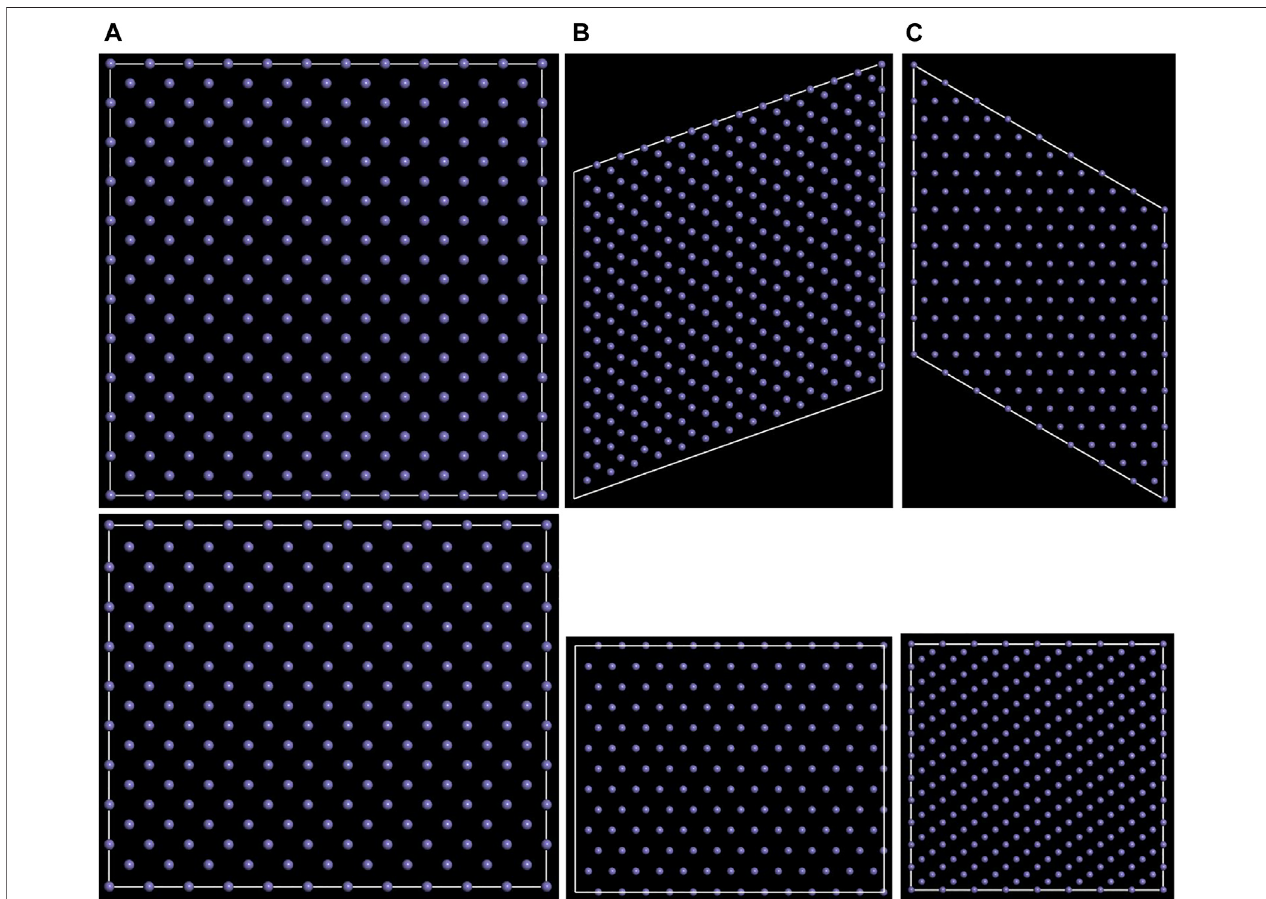
FIGURE 1 | Top (above) and side (below) views for the (A) (100), (B) (110), and (C) (111) surface models of α -Fe.